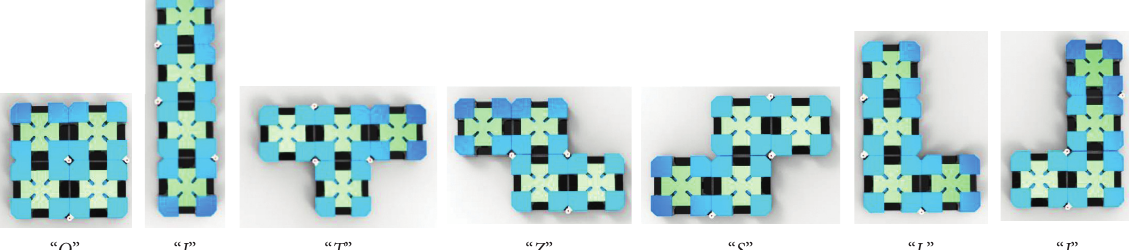
Figure 1: Seven distinct morphologies considered by P-hTetro for reconfiguration.